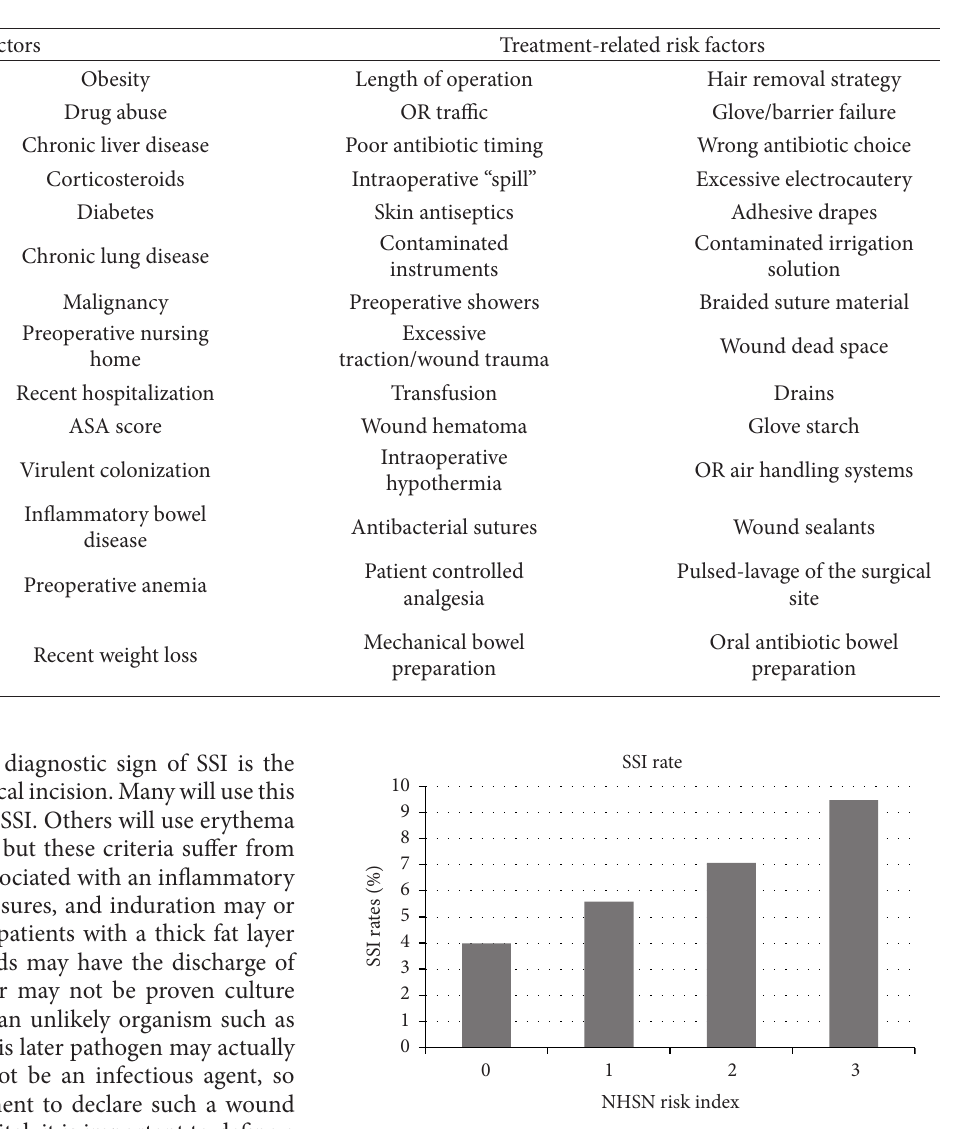
Table 2: Identifies the patient risk factors and the treatment-related risk factors that influence SSI rates in patients undergoing elective colectomy.